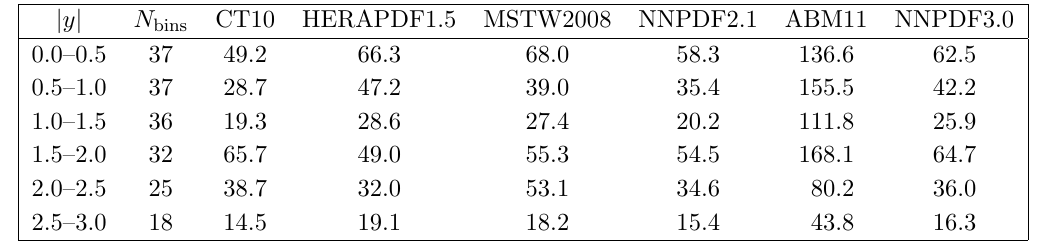
Table 3 . Summary of the (cid:31) 2 values for the comparison of data and theoretical predictions based on di(cid:11)erent PDF sets in each j y j range, where cross sections are measured for a number of p T bins N bins